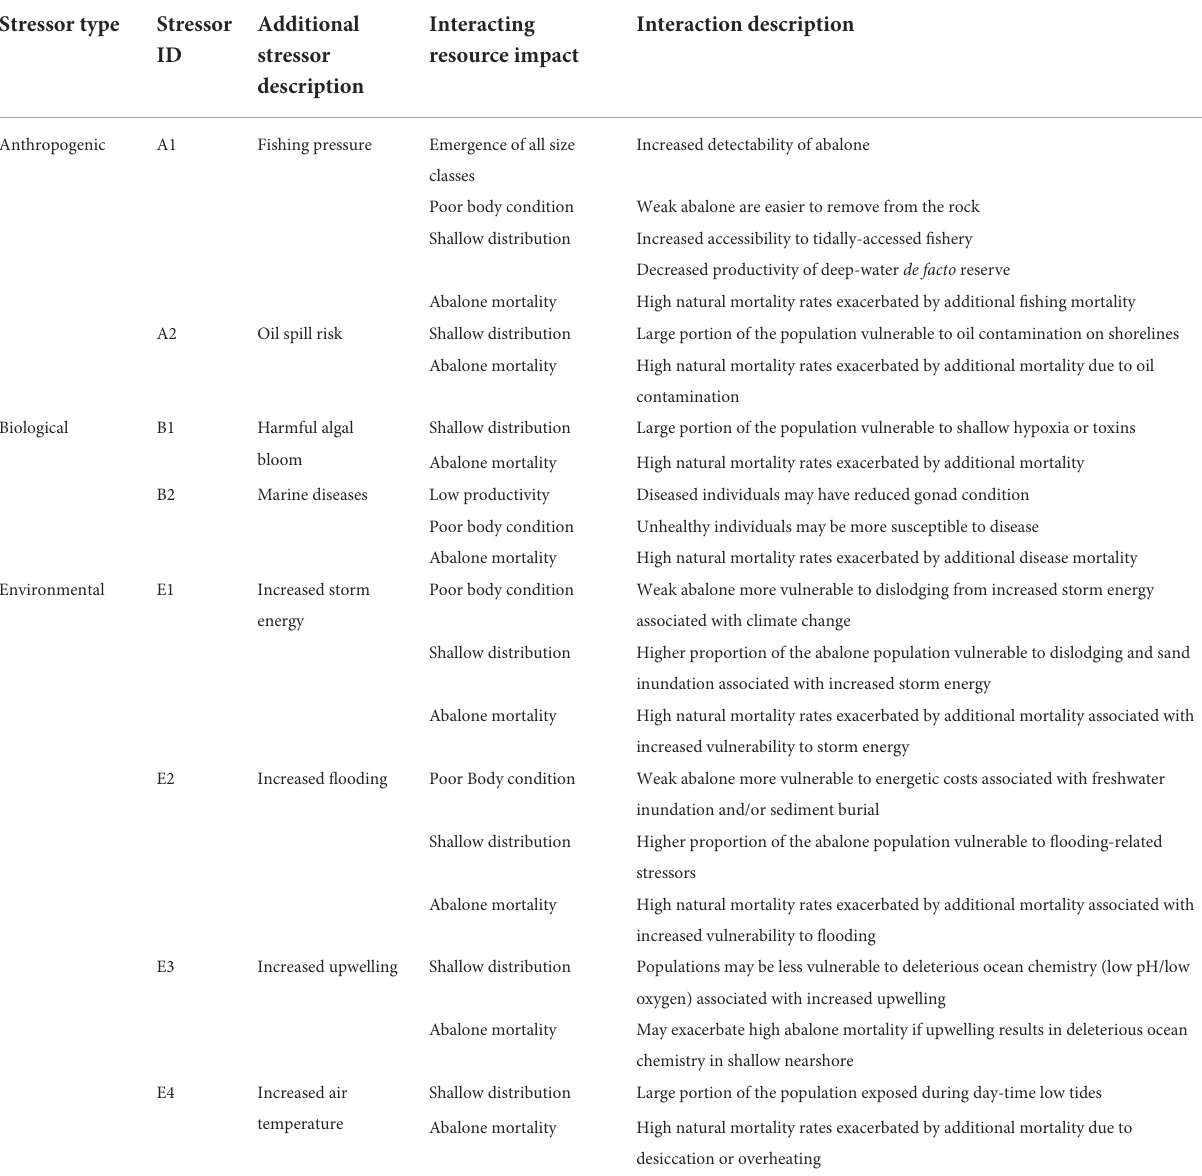
TABLE 3 Conceptual model—detail of red abalone vulnerability to additional